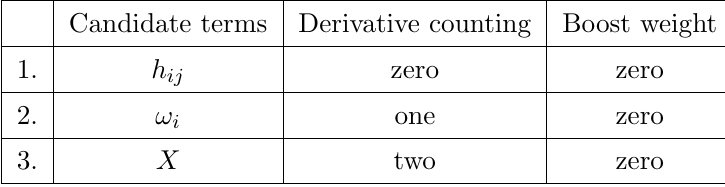
Table 2 . The basic building